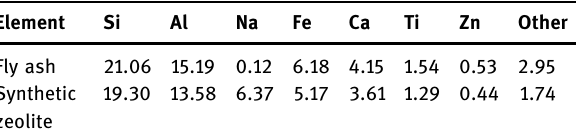
Table 2: Water quality composition of phosphorus wastewater